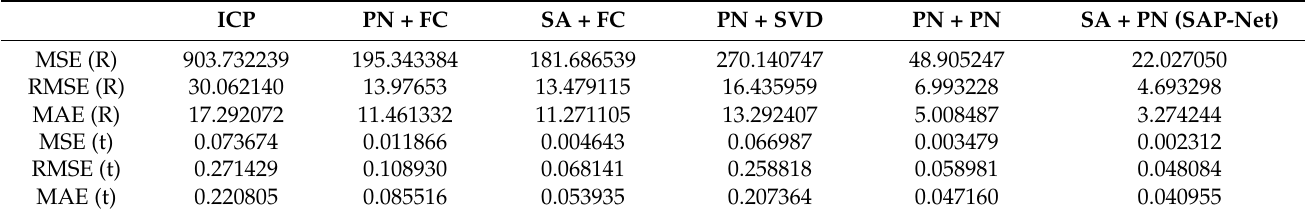
Table 4. Test on different categories.